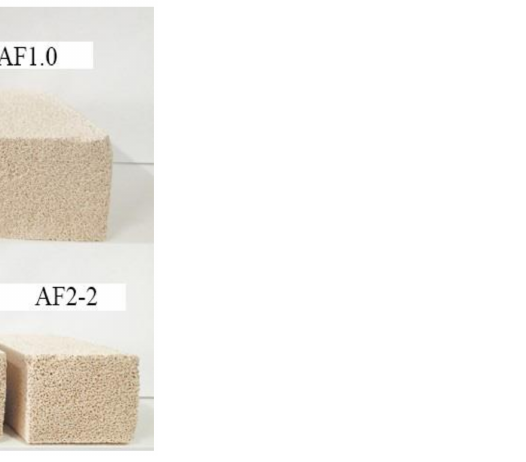
Figure 4. Optical photographs of AFs with ( a ) different AA modules and ( b ) different pressure and time.